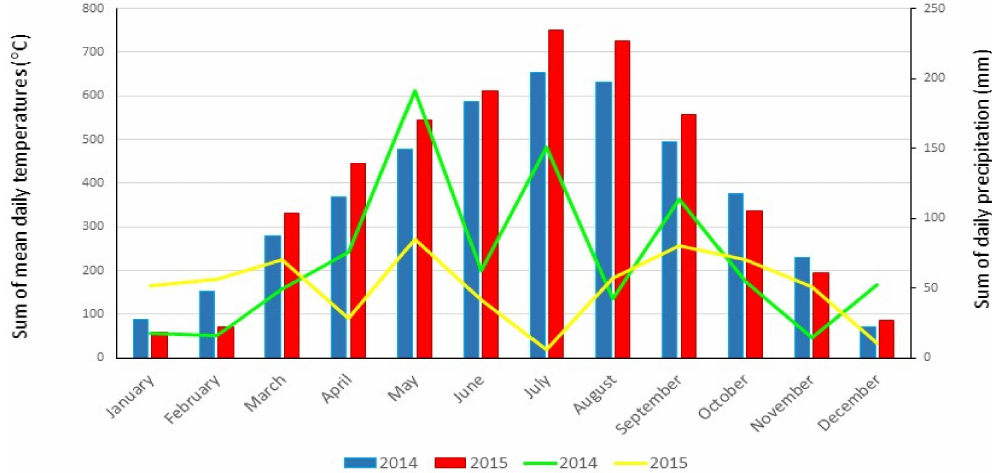
Figure 1. The sum of the mean daily temperatures (bars) and the sum of the daily precipitation (lines) during the two experimental seasons